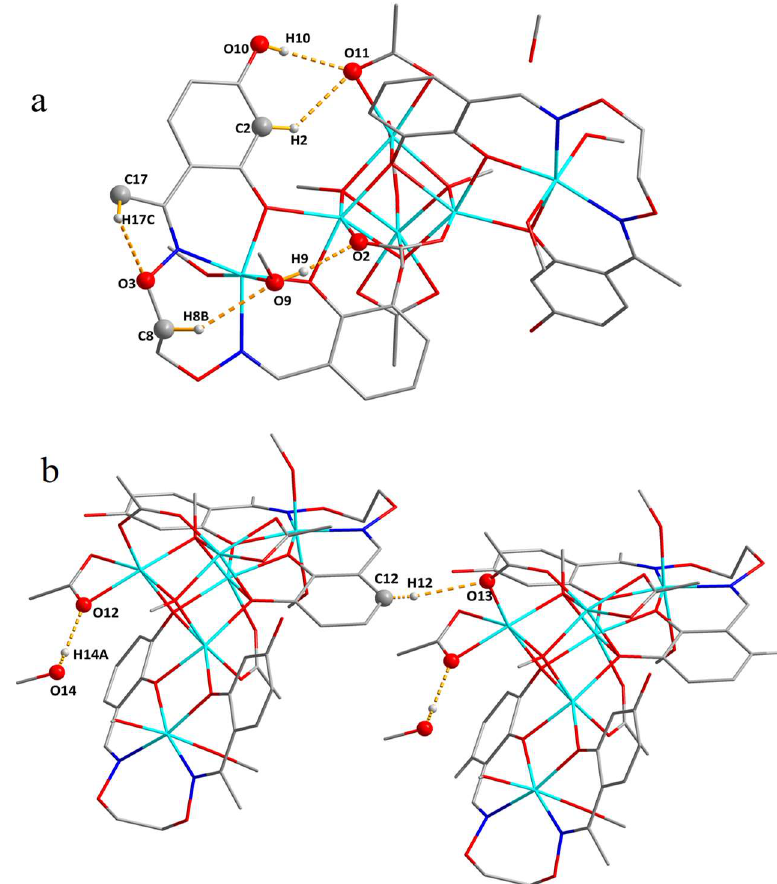
Figure 2. View of the intramolecular ( a ) and intermolecular ( b ) interactions of the Co(II) coordination compound.